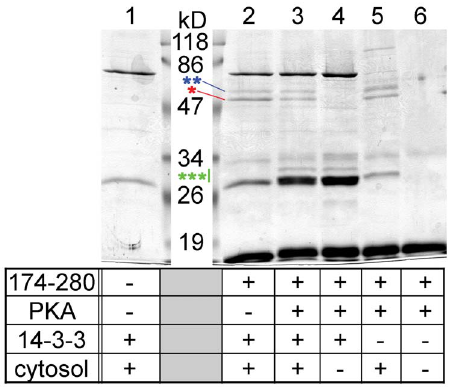
Figure 8. The adaptor protein 14-3-3 competes with tubulin for the binding to TRESK. TRESK-loop-His 8 (amino acids 174–280 of the human channel; immobilized on Ni-NTA resin) was ( lane 3 ) or was not ( lane 2 ) phosphorylated with protein kinase A (PKA). The bait was incubated with supernatant from E. coli expressing 14-3-3 g adaptor protein without fusion tag. Subsequently, mouse brain cytosol was added, and pull-down assay was performed. The binding of 14-3-3 to the phosphorylated bait is apparent in the 30 kD range (as indicated with a green triple asterisk ; compare lane 3 to 2 ). Calcineurin ( blue double asterisk ) interacted identically with the non-phosphorylated ( lane 2 ) and the 14-3-3-preloaded bait ( lane 3 ). In contrast, more tubulin (indicated with a red asterisk ) was pulled down by TRESK-loop-His 8 with no bound 14-3-3 ( lane 2 ) than by the bait preloaded with the adaptor protein ( lane 3 ). Several control reactions were also performed (as indicated in the table below the gel) to demonstrate that the bands corresponding to tubulin and calcineurin were of cytosolic origin ( lanes 2 and 3 vs. 4 ), to determine the source of 14-3-3 binding to TRESK-loop-His 8 (bacterial supernatant or brain cytosol, lane 3 vs. 5 ), to identify the bands belonging to the bait and PKA preparations ( lane 6 ) and to illustrate the non-specific interactions of Ni-NTA resin in this experiment ( lane 1 ).